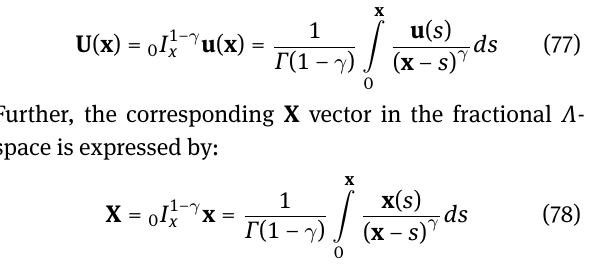
Further the distributed body force in the initial space has also been computed through,